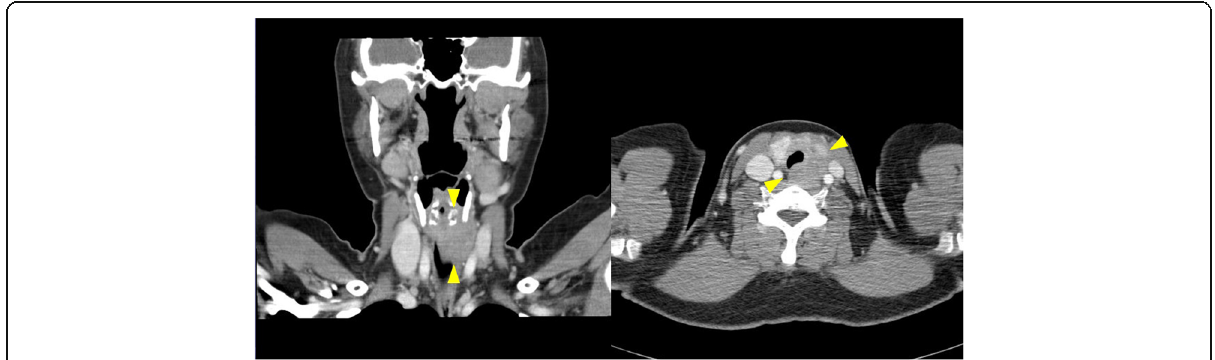
Fig. 1 CT scan revealed a 4 cm hypodense mass with ill-defined margin at posterior-lower part of left thyroid gland (arrow heads), accompanied by multiple enlarged neck lymph